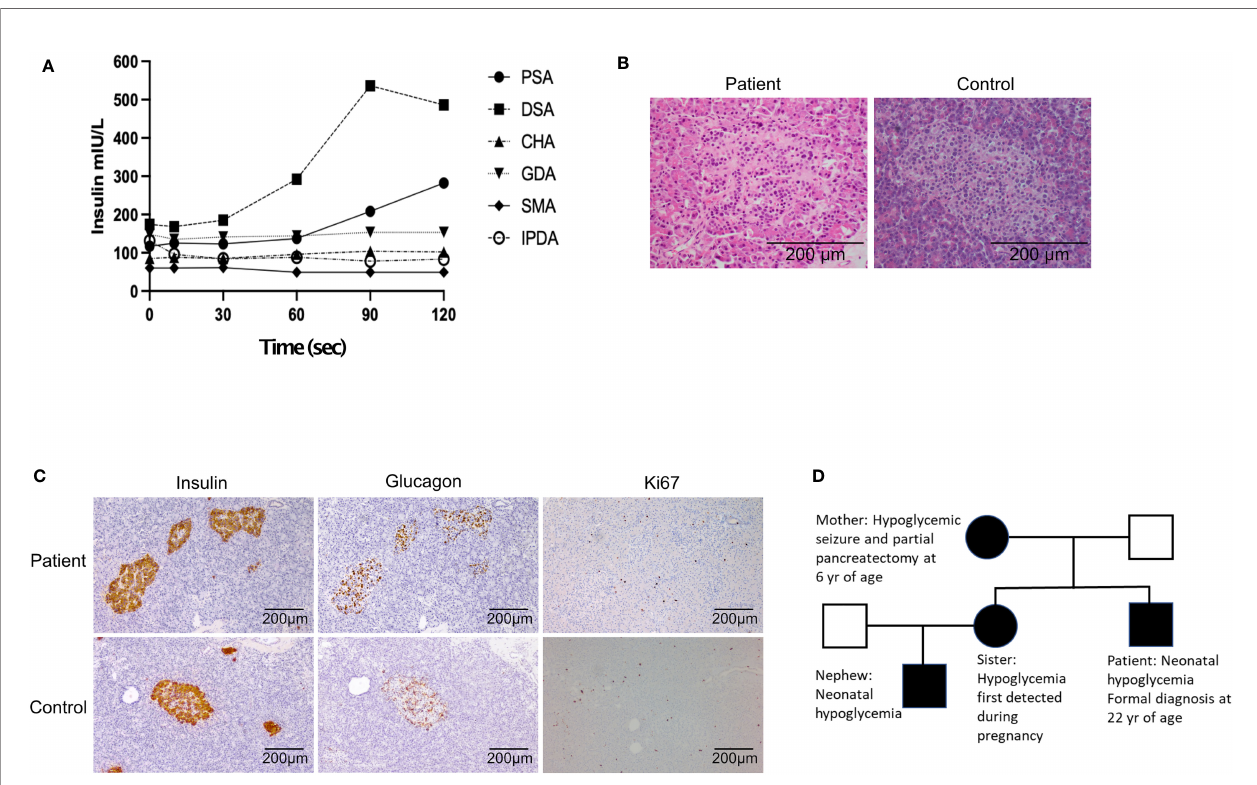
FIGURE 1 | (A) Selective arterial calcium stimulation test: Insulin level obtained during a selective arterial calcium stimulation test. Increased hepatic vein insulin when calcium gluconate (0.025 mEq Ca 2+ /kg diluted to a 5-mL in normal saline, given as rapid bolus) was injected into the distal splenic artery suggested a focal abnormal insulin production in the region the body and tail of the pancreas. PSA, proximal splenic artery; DSA, distal splenic artery; CHA, common hepatic artery; GDA, gastro duodenal artery; SMA, superior mesenteric artery; IPDA, inferior pancreatico duodenal artery. (B) Hematoxylin and eosin high power (x200) - variation in size of islet cell nuclei. (C) Representative histology of patient (top panels) and control (bottom panels) pancreas sections stained with antibodies recognizing insulin, glucagon and Ki67. (D) Pedigree of patient. Black represents individuals with con fi rmed GCK